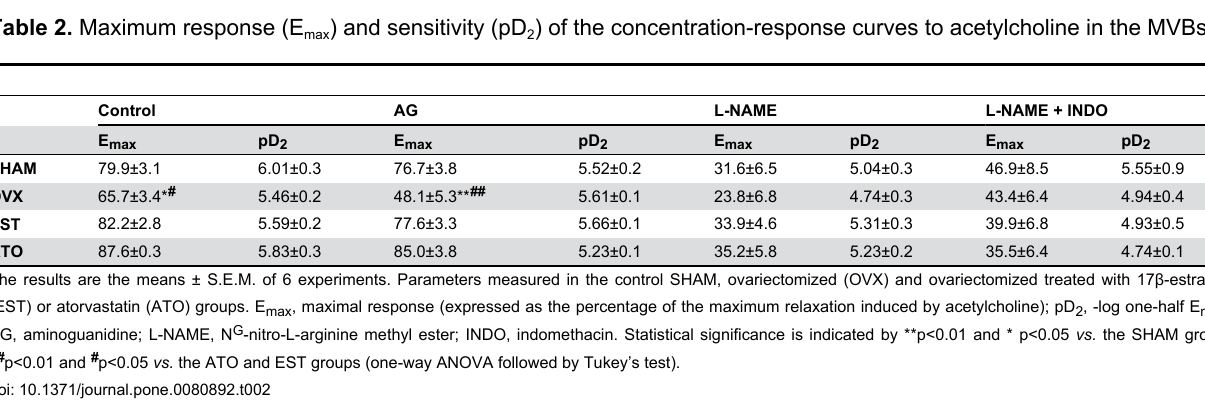
Table 2. Maximum response (E